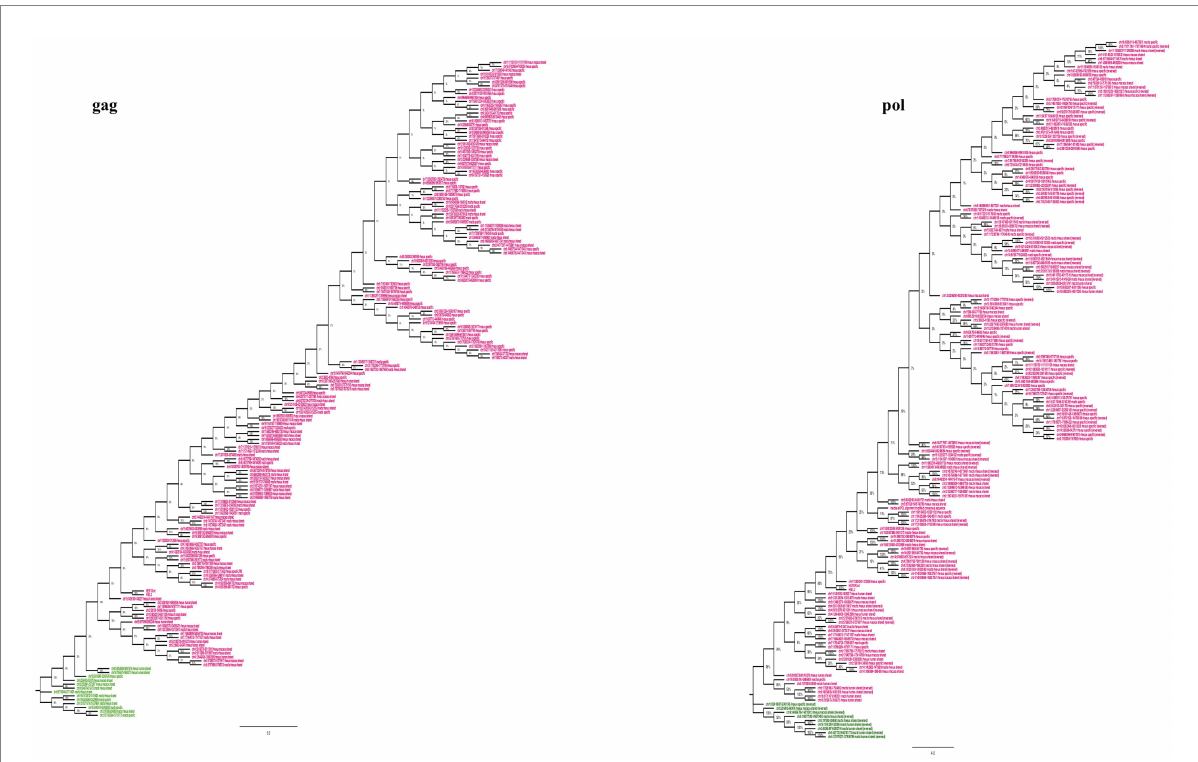
FIGURE 5 Phylogeny of HML2 gag and pol genes of macaque species. The trees represent the conservative nature of gag and pol genes of HML2 in both the Macaca species with the major upper cluster of bootstraps 100% ( gag ) and 98% ( pol ). The major cluster is highlighted in pink while the ones highlighted in green are the